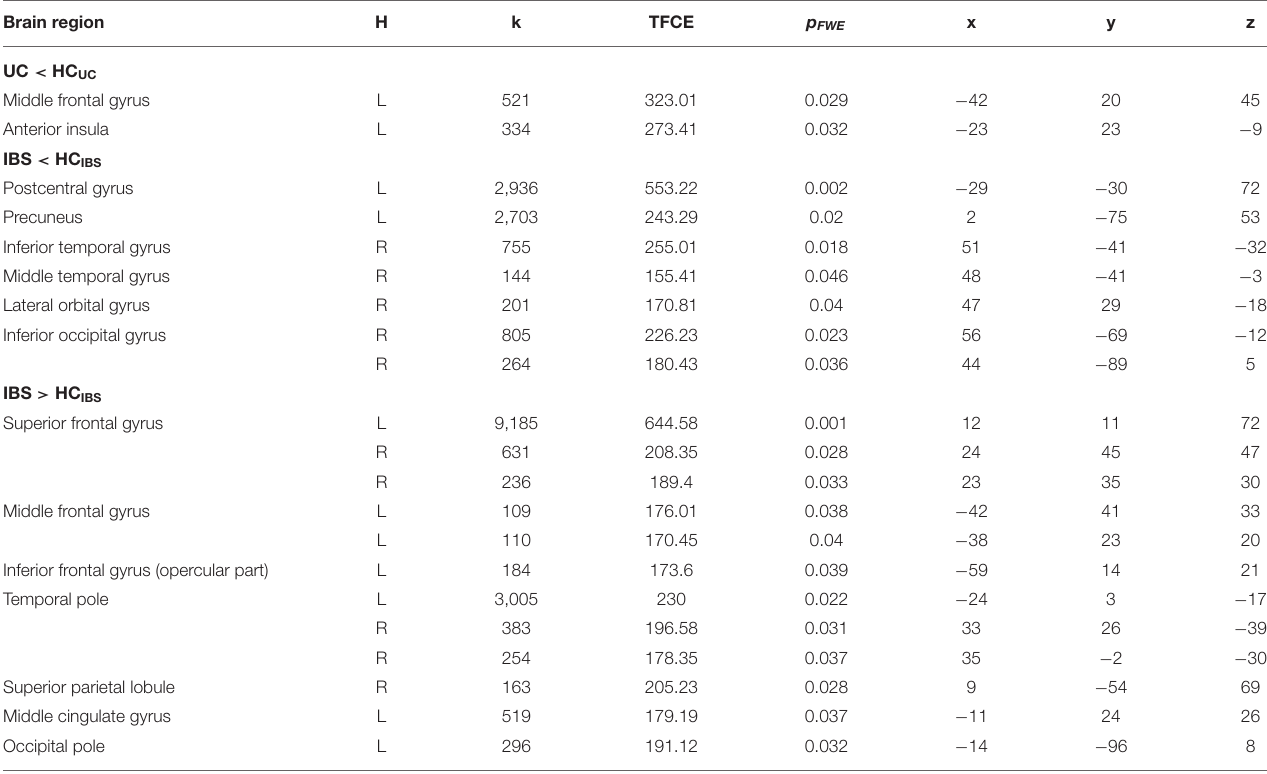
TABLE 2 | Results of whole-brain ANCOVAs comparing gray matter volume in the two patient groups to healthy controls. Brain region H k TFCE UC < HC UC Middle frontal gyrus Anterior insula